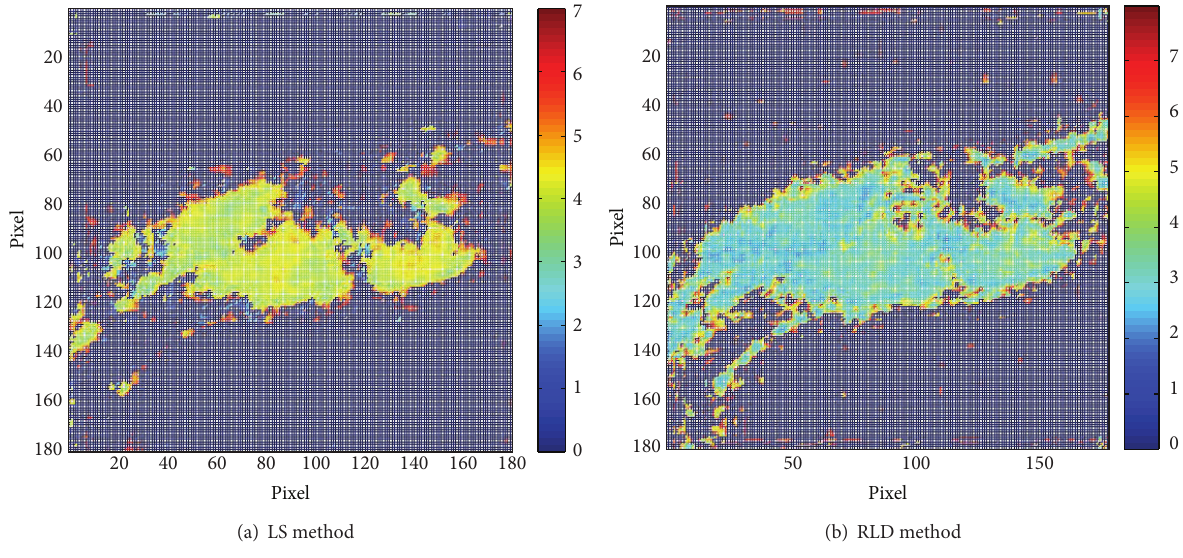
Figure 3: Stimulated result of nematode gated image.